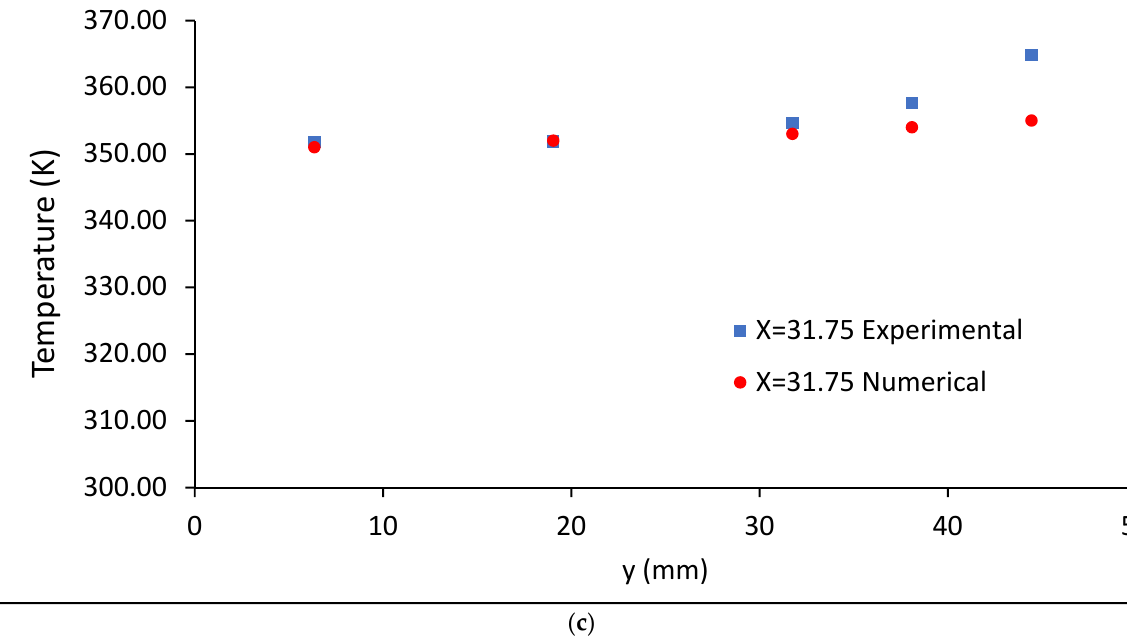
Figure 10. Comparison between EPS models’ prediction and the experimental data of [67] at an average air speed of 2.71 m/s, at the axial location form the inlet: ( a ) 6.35 cm, ( b ) 19.05 cm, ( c ) 31.75 cm. Table 4. Percentage error between the EPS models’ predicted and experimental temperatures at an air speed of 2.71 m/s.